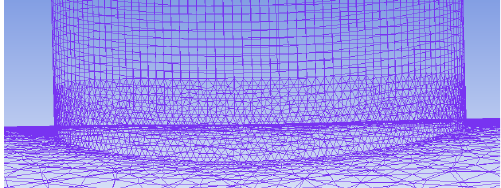
Figure 2. Mesh details of steam nozzles.